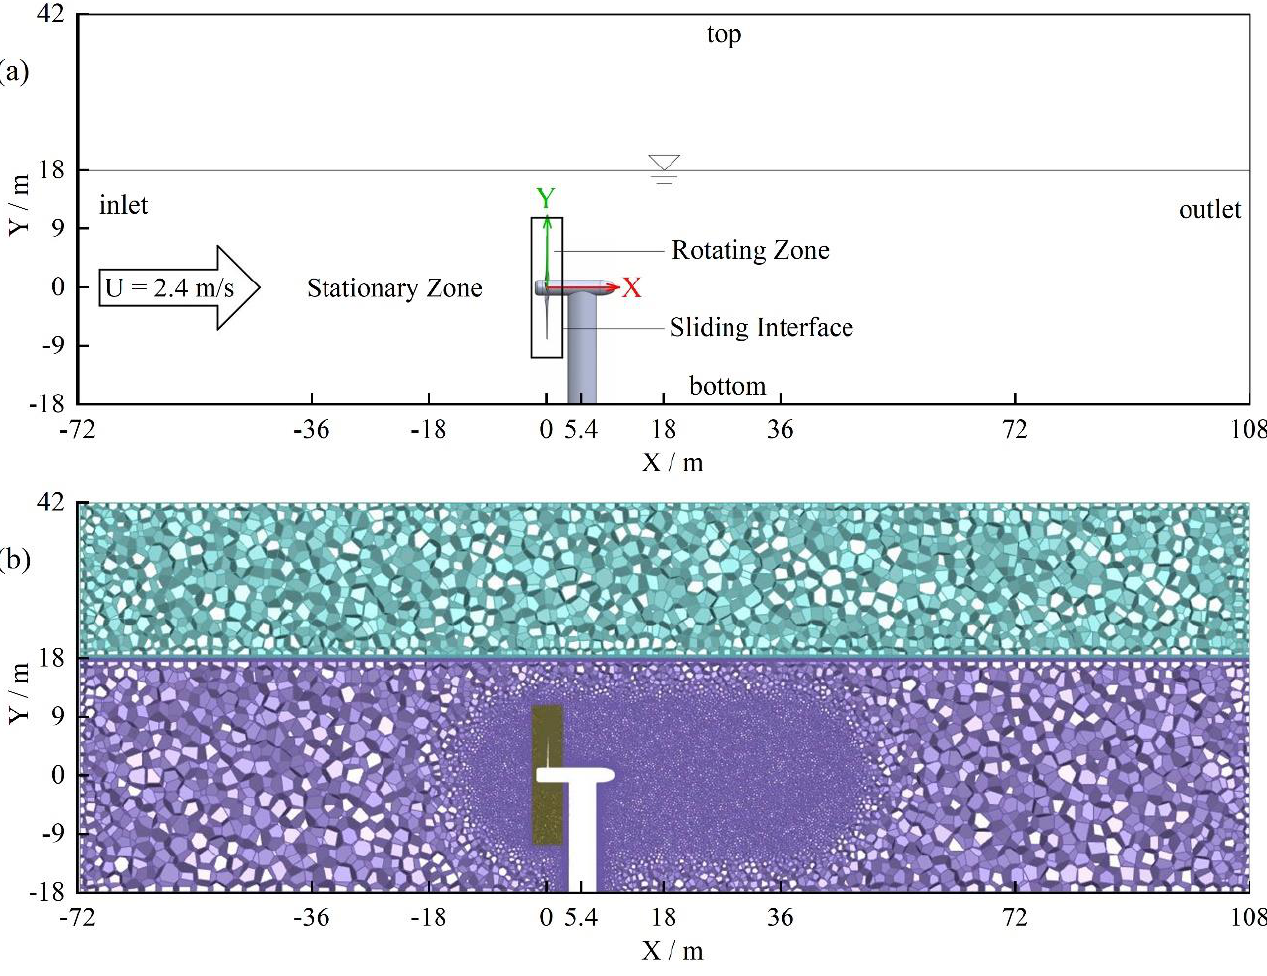
Figure 5. Computational domain of the full-scale simulation, ( a ) for the boundary and zone setting, ( b ) for the mesh at z = 0. This simulation employs a Cartesian coordinate system with the origin located at the intersection point of three centerlines of blades, as shown in Figure 5a. The positive X-axis is in the streamwise direction, and parallel to the centerline of the rotor. The positive Y-axis is in the opposite direction of gravity, and the positive Z-axis is outside the paper in Figure 5a. Therefore, the direction of rotation is ( − 1 0 0) according to right-hand rule. The cell-related lengths employed in the full-scale simulation are similar to the sim- ulations for Exp. 1 and 2. To test the mesh convergence, three sets of rotor mesh named as mesh 1 (0.71 × 10 6 cells), mesh 2 (0.99 × 10 6 cells), and mesh 3 (1.37 × 10 6 cells) were compared. Taking TSR = 6 as instant, The C P of the three sets is 0.401, 0.427, and 0.436, respectively, while the C T of three sets is 0.852, 0.851, and 0.846, respectively. According to the definition of NACA [43], the GCI 23 (Grid Convergence Index of mesh 2 and mesh 3) for C P is 0.0135, and the GCI 23 for C T is 0.0085. Therefore, the set of mesh 3 was adopted, and the rotor mesh size sets for different surfaces and zones stay unchanged for following simulations. The mesh for whole computational domain is shown in Figure 5b. The total number of cells in rotating and stationary zone is a little more than 2.0 × 10 6 . The y+ of the whole turbine ranges from 20 to 300 in most cases. However, only very small surface has a y+ less than 30, and the y+ of the leading edge is always more than